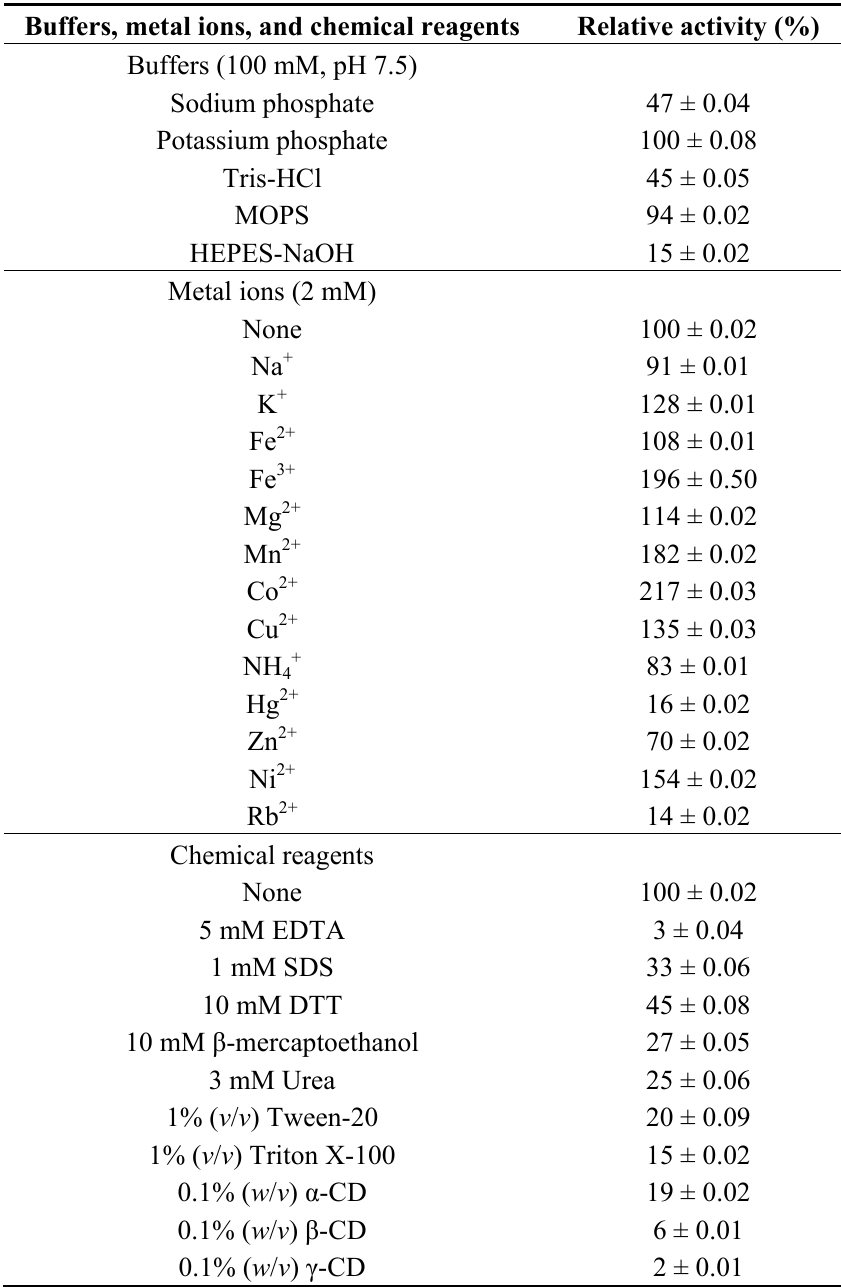
Table 2. Effects of different buffers, metal ions, and chemical reagents on the activity of